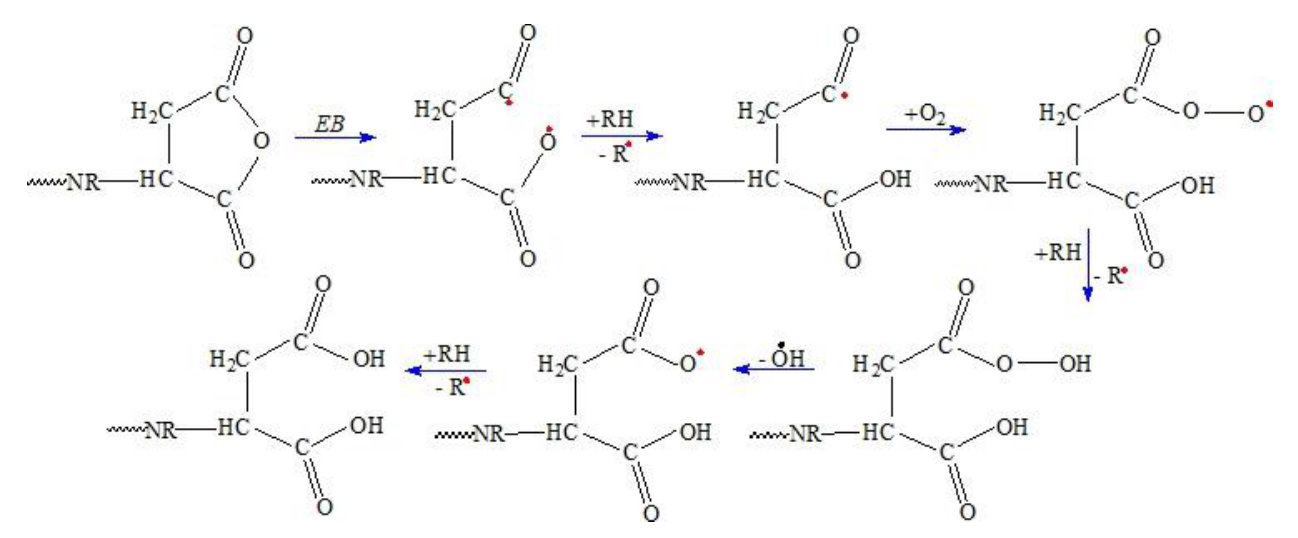
Scheme 6. Proposed degradation mechanisms for maleated NR.